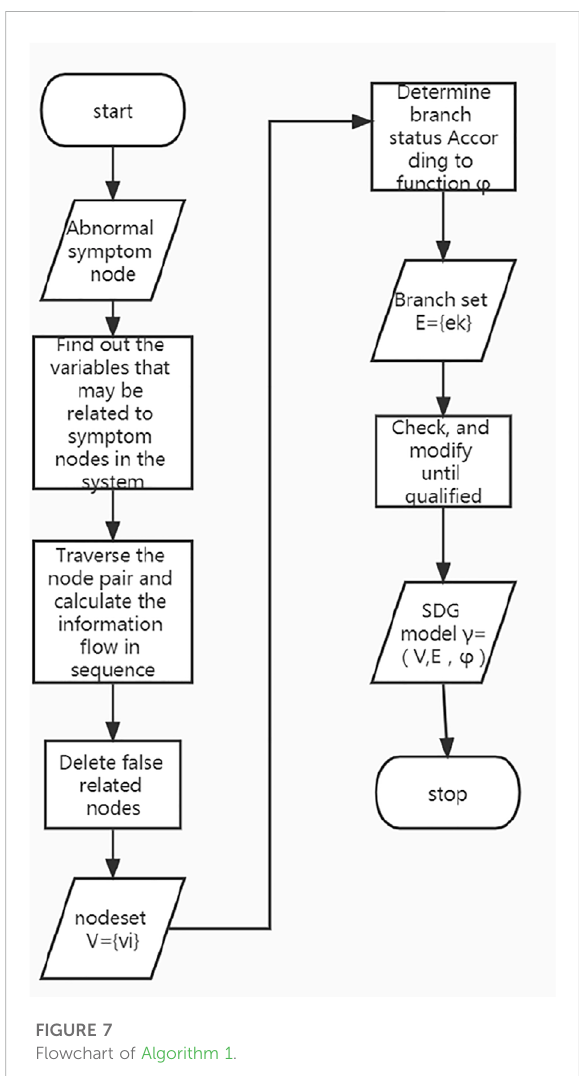
FIGURE 7 Flowchart of Algorithm